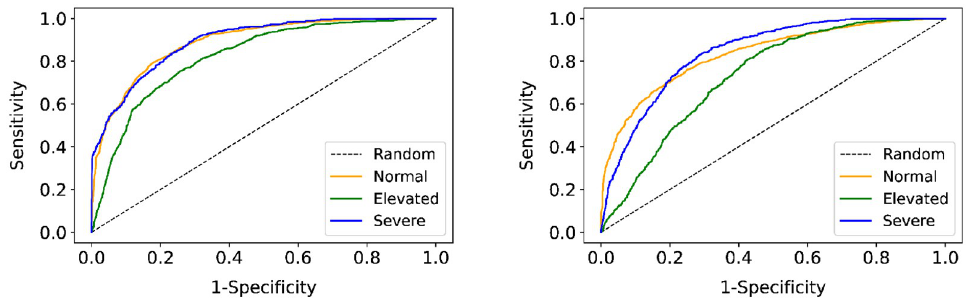
Fig 5. Receiver operating characteristic (ROC) curves for (a) FLI+ and (b) FLI to distinguish the presence or absence of fatty liver. Normal group represents non-fatty liver whereas elevated and severe represent fatty liver. (a) FLI+. (b) FLI.